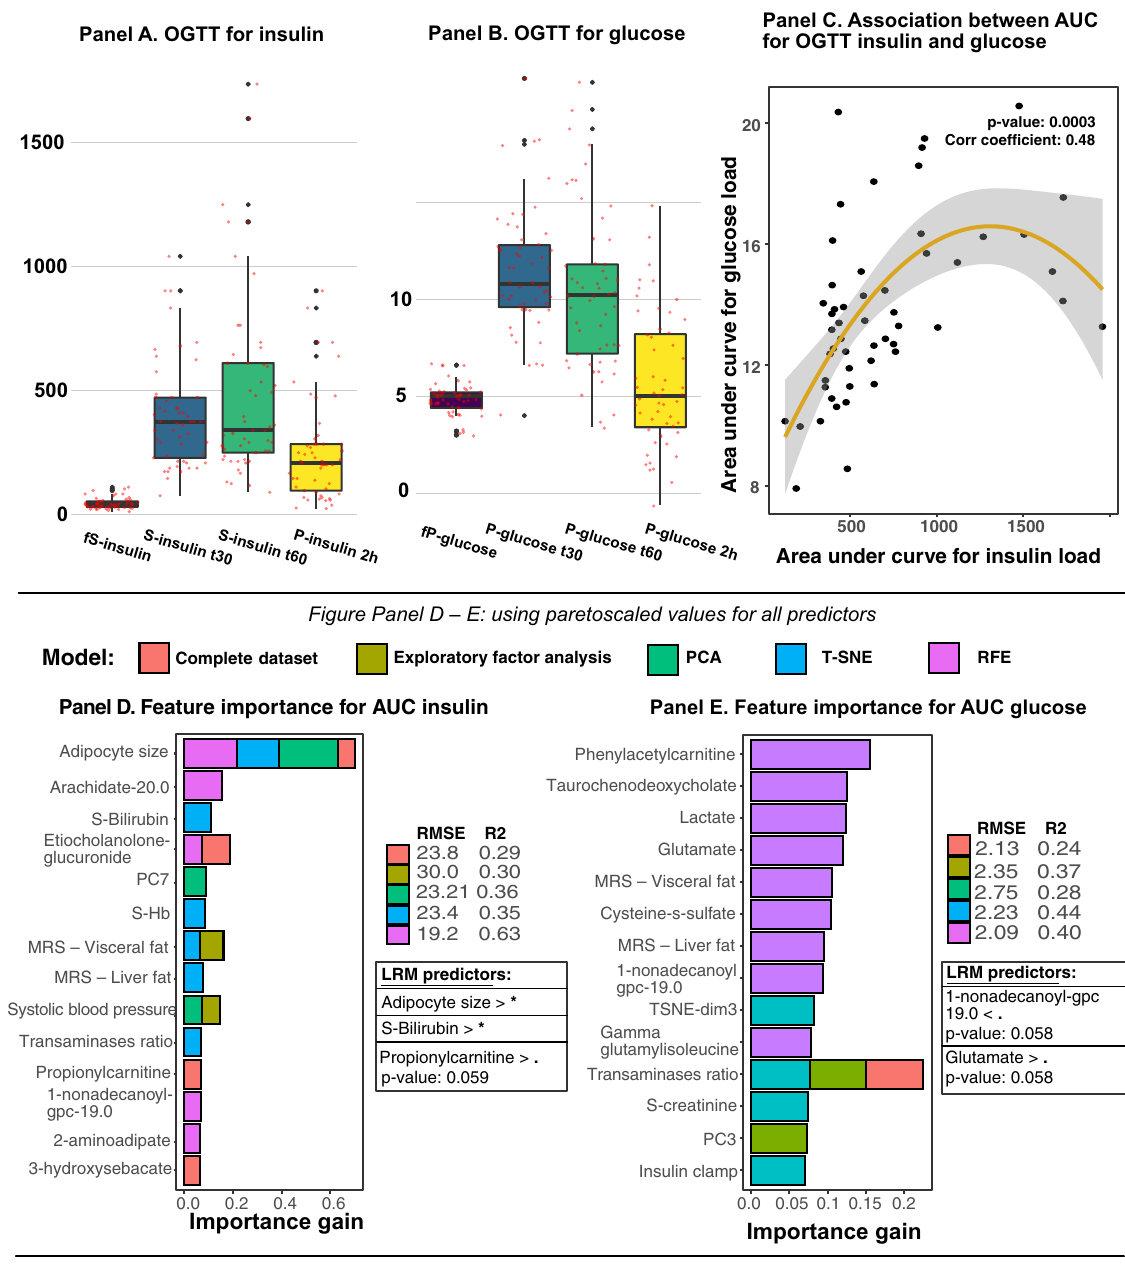
Figure Panel A – C: using unscaled original values for all predictors